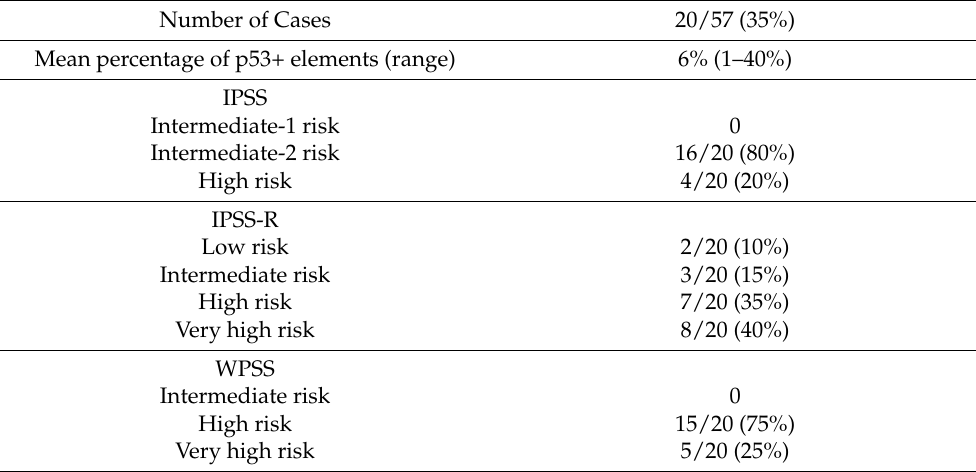
Table 4. Cases with ≥ 1% p53+ elements. Only pre-treatment bone marrow biopsies were